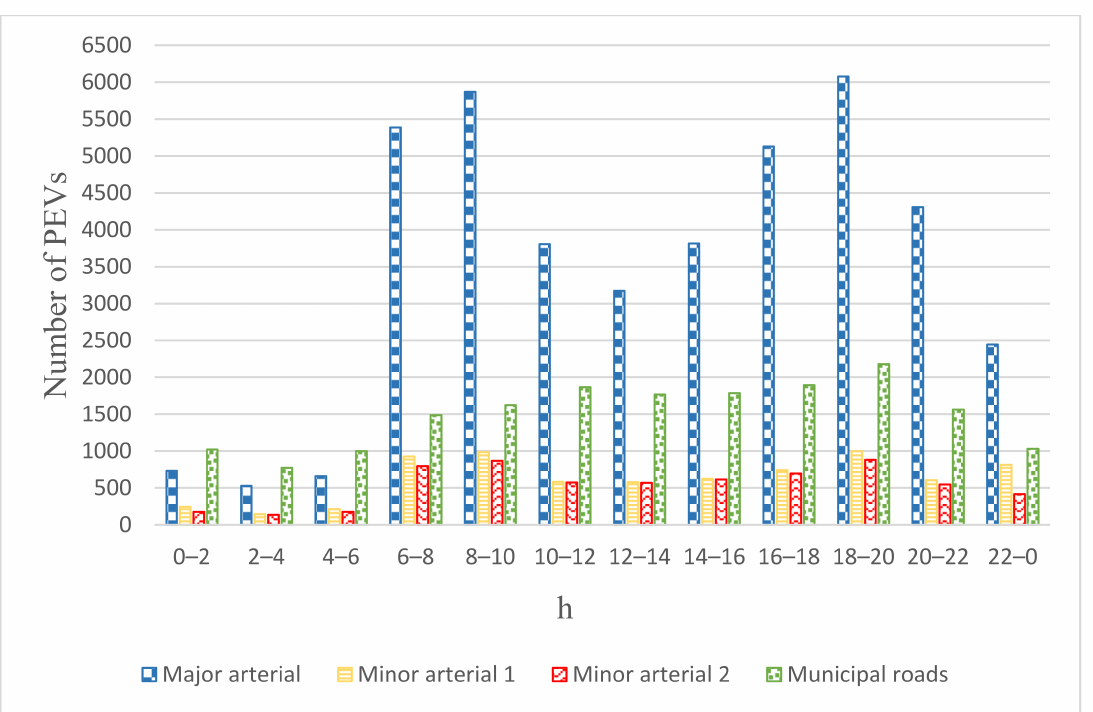
Figure 3. Illustration of traffic volumes in the original